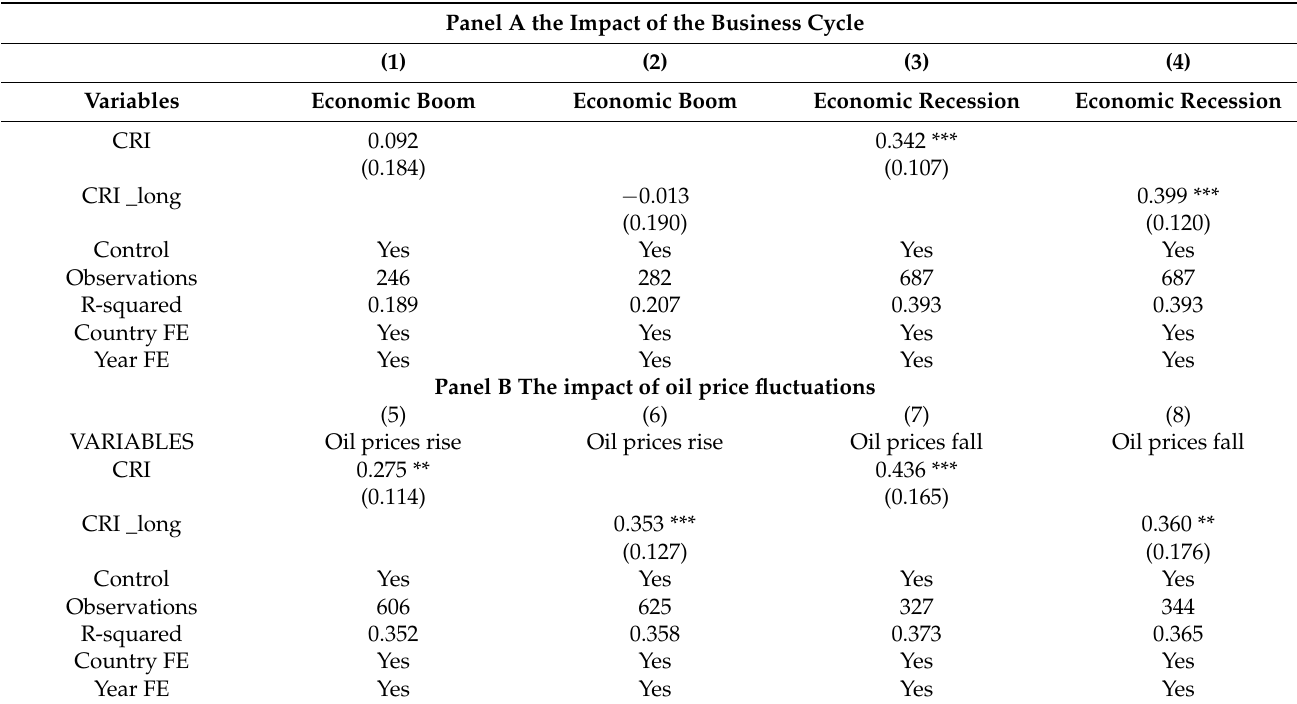
Table 9. Estimation results of the external impact